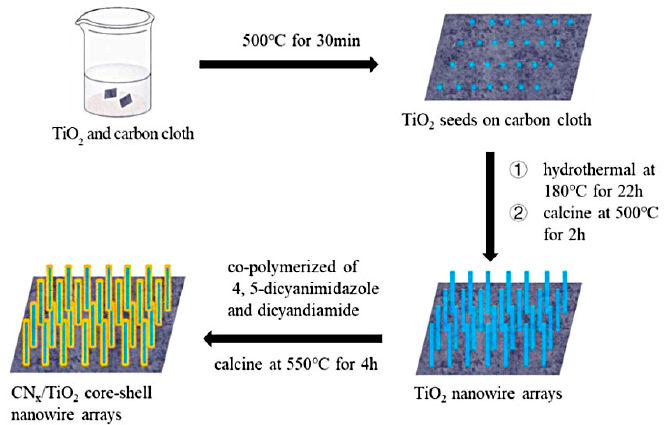
Figure 1. Schematic illustration of CN x /TiO 2 core-shell nanowire arrays.